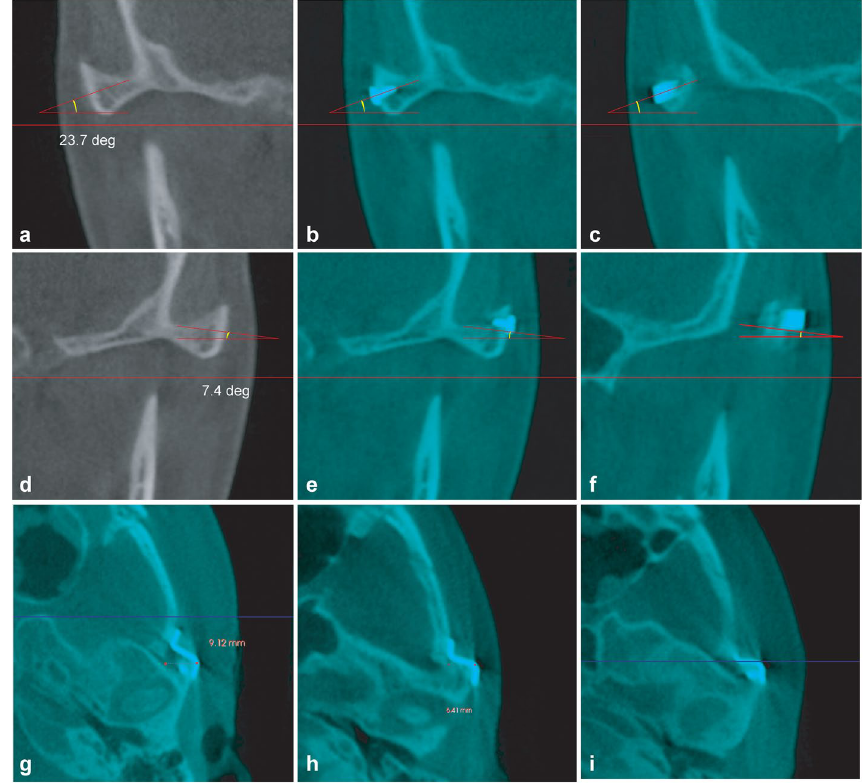
Fig. 6 Insufficient inward movement of the arch with degree of arch plate bending. a – f Inclination of the arch in the coronal plane leading to upward arch fixation. g Anterior arch movement due to interference of the arch with the temporal bone. h , i Anterior arch movement according to the curvature of the cut